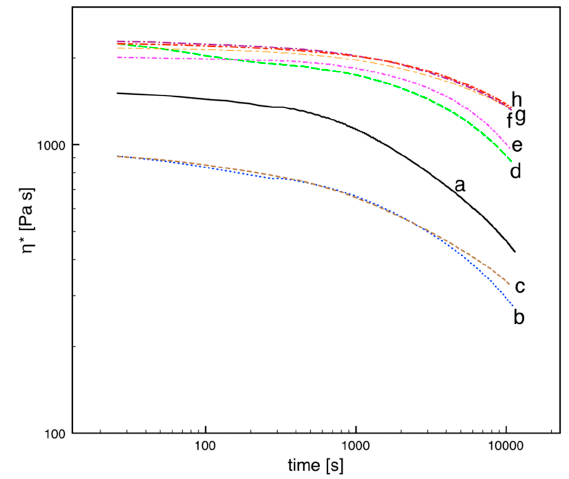
Figure 4. Time sweep-complex viscosity for the virgin pellet ( a ) and for extruded PLA samples after microcompounding: ( b ) neat and with ( c ) 0.1 wt % of LSAG; ( d ) 1 wt % of LSAG; ( e ) 0.1 wt % of HSAG; ( f ) 1 wt % of HSAG; ( g ) 0.1 wt % of CB; ( h ) 1 wt % of CB. Experimental conditions: T = 200 °C, f = 1 rad/s, plate–plate, gap = 200 μ m.